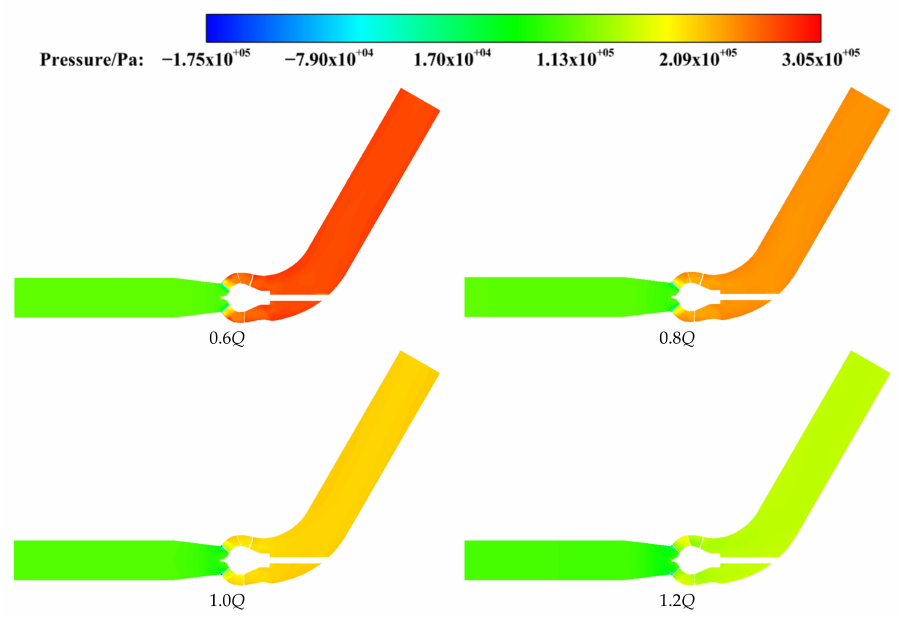
Figure 7. Pressure distributions in the runner under different flow rate conditions.